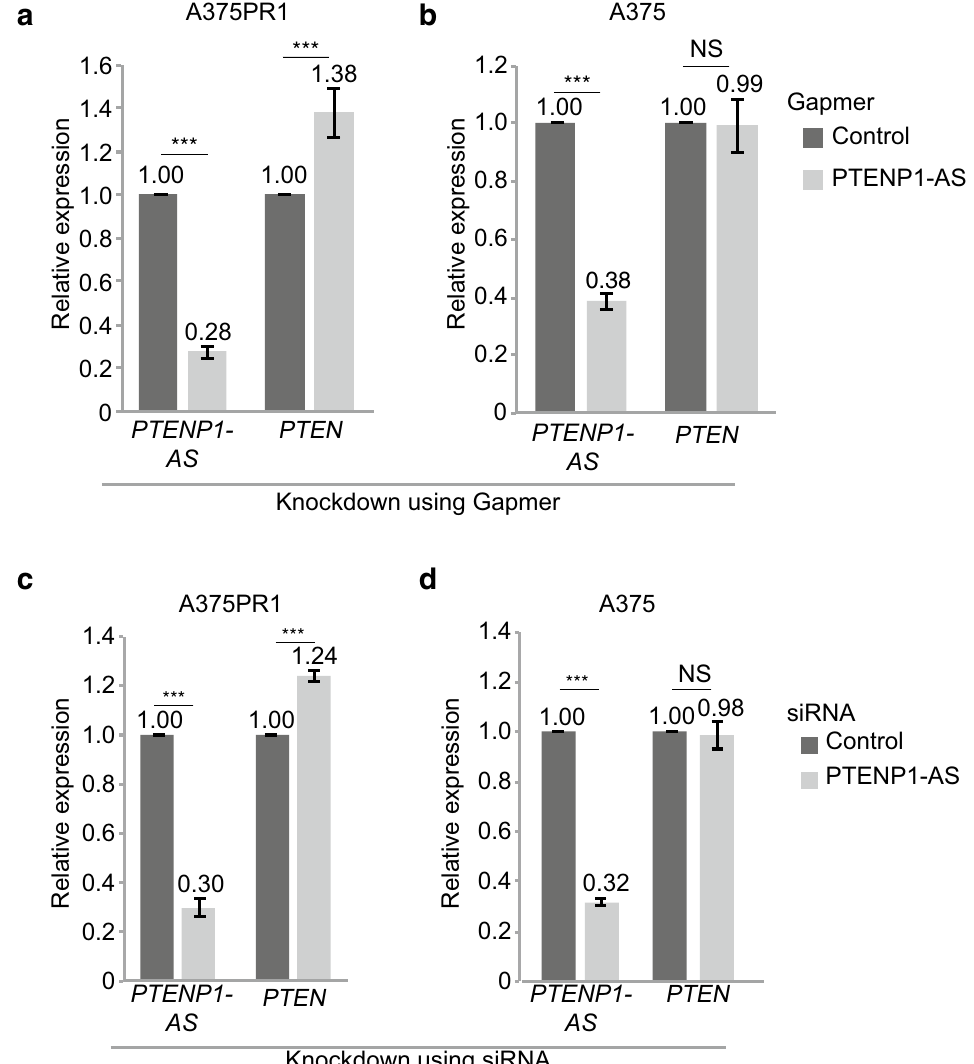
Figure 2. Effect on PTEN expression upon knockdown of PTENP1-AS . ( a , b ) qRTPCR measuring the expression levels of PTENP1-AS and PTEN in ( a ) A375PR1 or ( b ) A375 cells upon knockdown of PTENP1-AS using gapmer ASO. ( c , d ) qRTPCR measuring the expression levels of PTENP1-AS and PTEN in ( c ) A375PR1 or ( d ) A375 cells upon knockdown of PTENP1-AS using siRNA. ( a – d ) n = 3, p-values represent two-tailed student’s